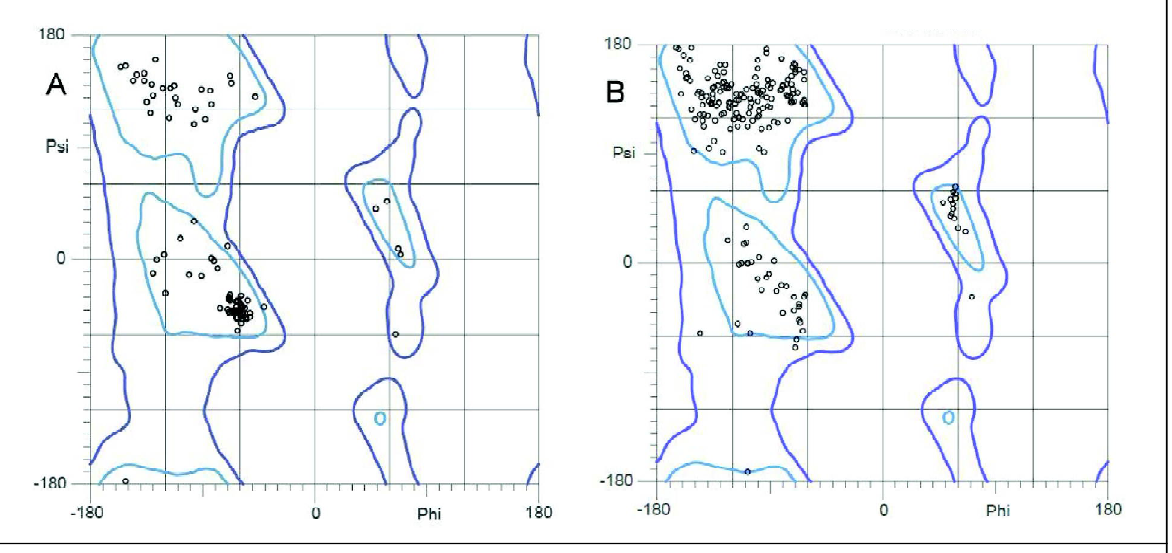
Figure 5: General case representations of the Ramachandran plot analysis representations of the selected protein receptor structures depicting the quadrant allocations of the constituent amino acid residues, as obtained from the MolProbity server: (A) BTB domain (PDB: 5DAD); (B) Kelch Domain (PDB: